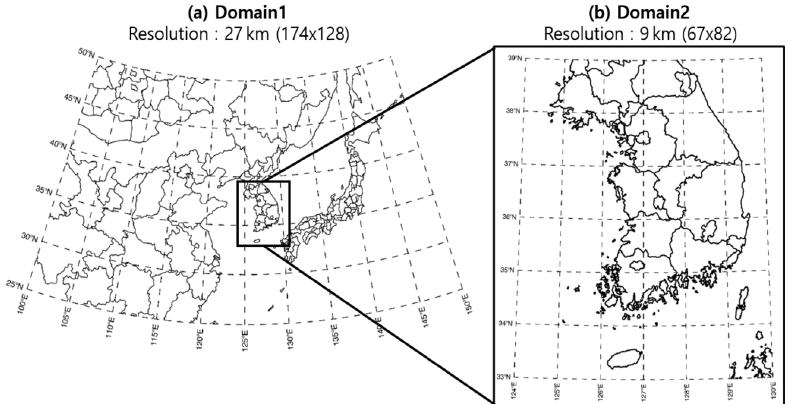
Figure 3. CMAQ modeling domains applied to generate the DNN model training data: (a) Northeastern Asian area with 27km horizontal grid resolution and (b) Korean Peninsula area with 9km horizontal grid